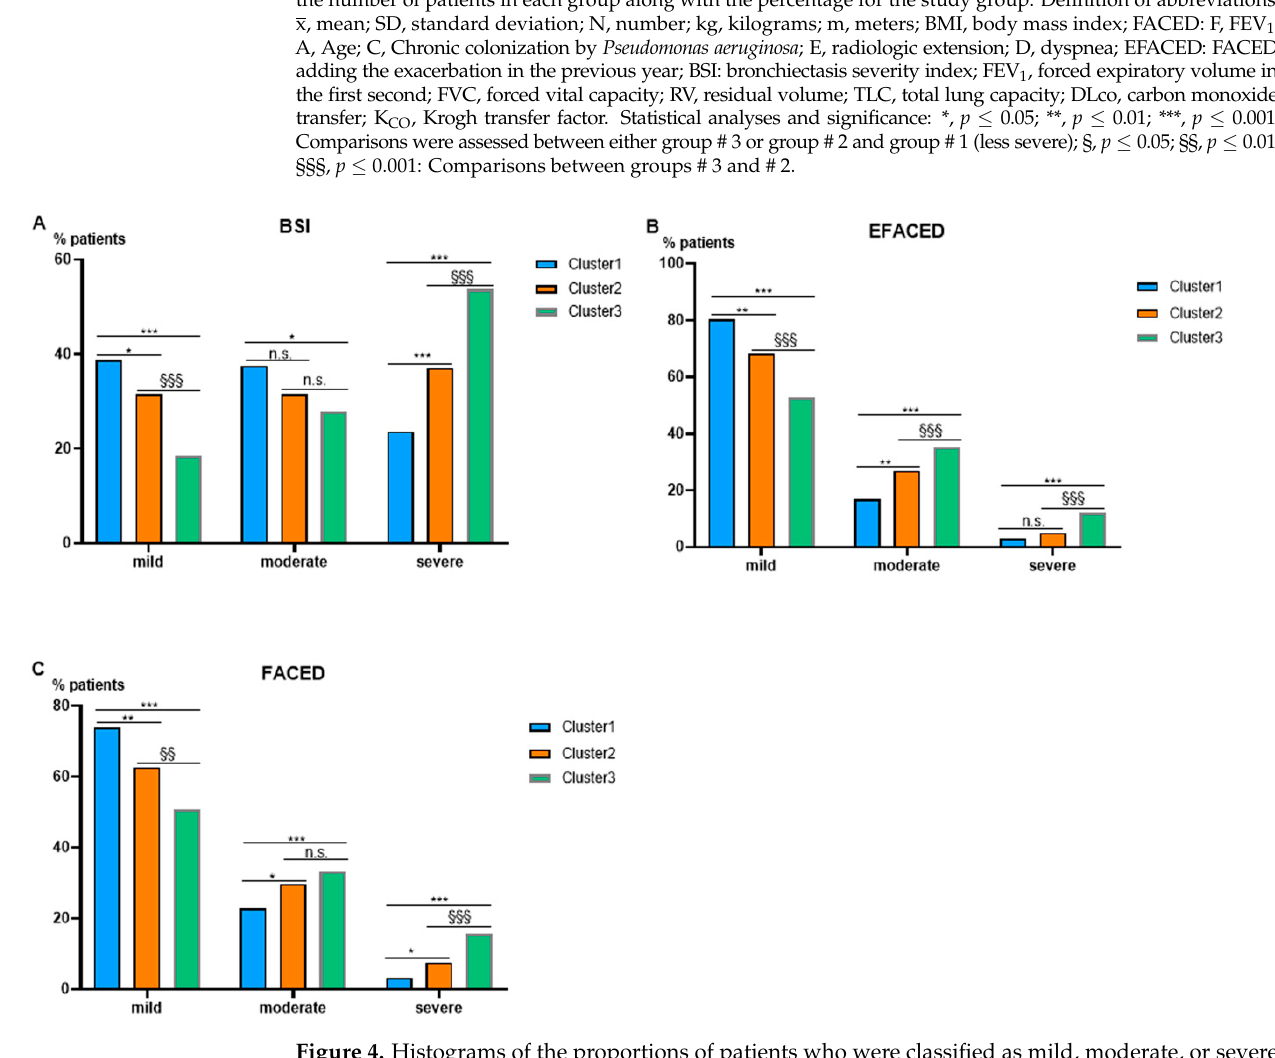
Figure 4. Histograms of the proportions of patients who were classified as mild, moderate, or severe according to BSI ( A ), EFACED ( B ) and FACED ( C ) among the three clusters. Score subdivisions were as follows: (1) BSI: mild: 0–4, moderate: 5–8, severe: ≥ 9, (2) EFACED: mild: 0–3, moderate: 4–6,